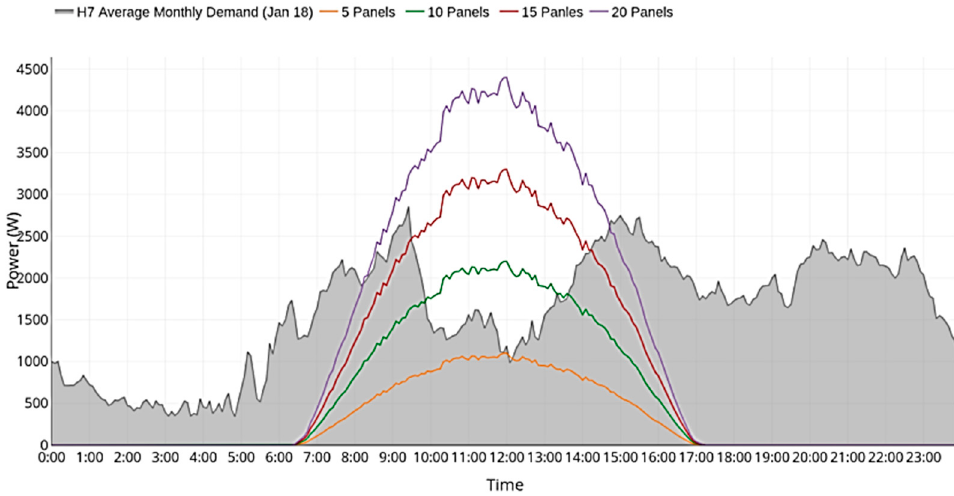
Figure 12. H2 (( a ) and ( b )) and H7 (( c ) and ( d )) power demand against 5, 10, 15, and 20 panels of PV power generation for the months of January and July 2018.